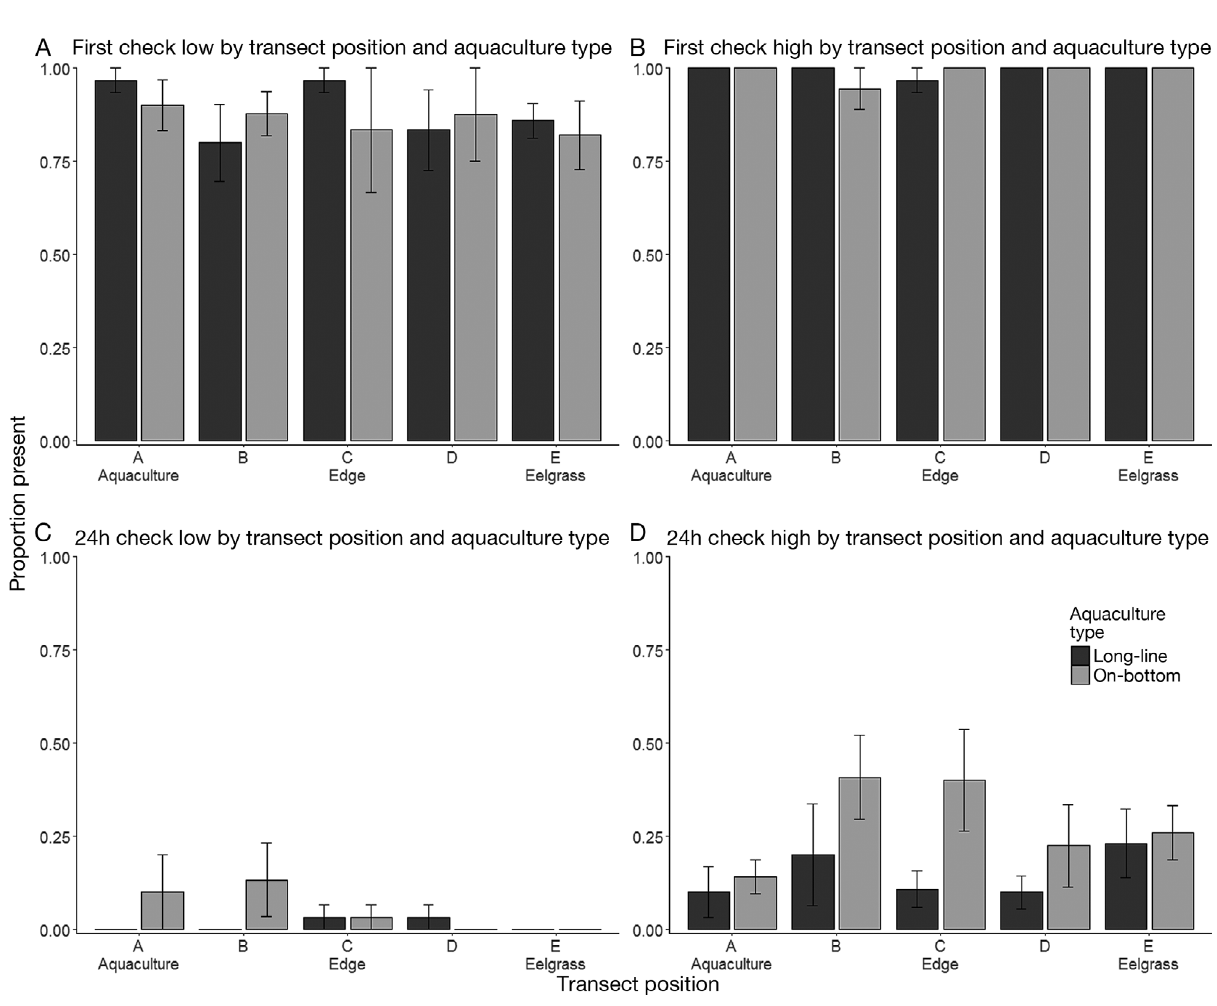
Fig. 6. Results of predation tethering unit arrays for both the (A,C) low treatment and (B,D) high treatment at the (A,B) first check and (C,D) 24 h check (N = 6). Error bars: ±1